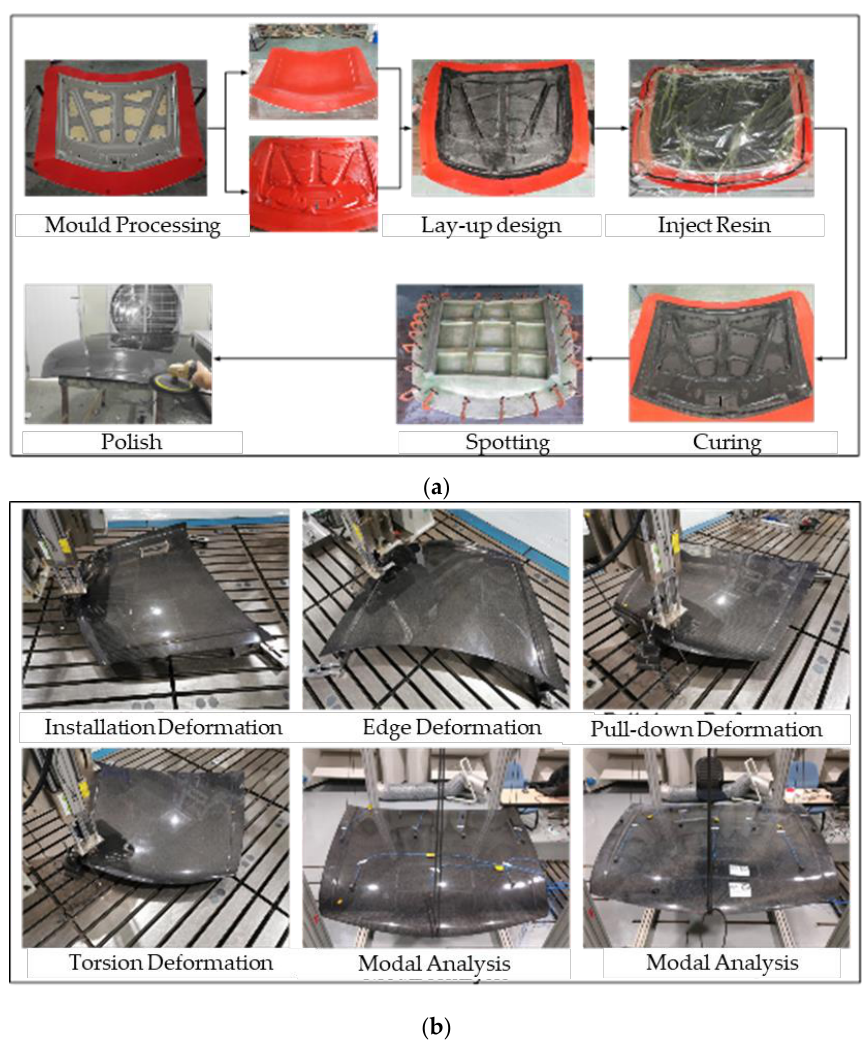
Figure 11. ( a ) engine hood manufacturing operation, ( b ) stiffness and modal tests of engine